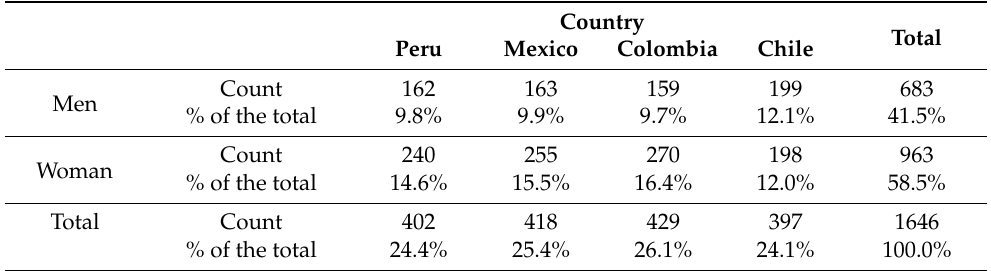
Table 1. Sociodemographic data of the sample by gender and country of origin.